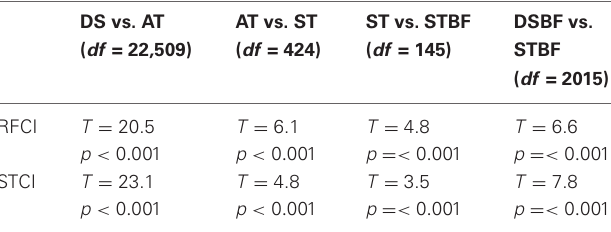
Table 3 | Response and receptive field correlation between neighboring neurons and their dependence on proximity and frequency